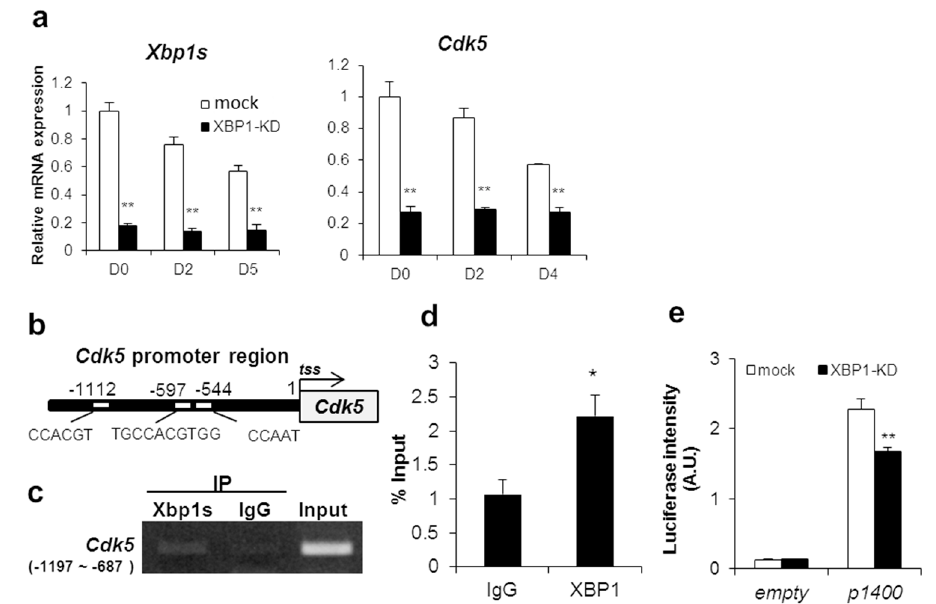
Figure 5. CDK5 is a downstream target of IRE1-XBP1 in C2C12 cells. ( a ) mRNA expression of Xbp1 and Cdk5 during C2C12 differentiation. Results are means + SEM (three biological replicates). Student’s t -test. ** p < 0.01. ( b ) An illustration of the predicted mouse Cdk5 promoter region. The region upstream of the Cdk5 gene comprises three XBP1-binding domains including CCAAT at − 544 bp, TGCCACGTGG at − 597 bp, and CCACGT at − 1112 bp from the transcription start site. ( c , d ) Chromatin immunoprecipitation assay using a C2C12 genomic sample. Input DNA = positive control. Rabbit IgG was used as negative control ChIP ( c ). ChIP assay was performed by quantitative PCR analysis ( d ). Results are means + SEM (three biological replicates). Student’s t -test. * p < 0.05. ( e ) XBP1-knockdown and mock cells were transfected with the vector containing the Cdk5 promoter construct ( p 1400) or an empty vector. Cdk5 promoter activity was assessed by luciferase assay. Results are means + SEM (three biological replicates). Student’s t -test. ** p < 0.01.